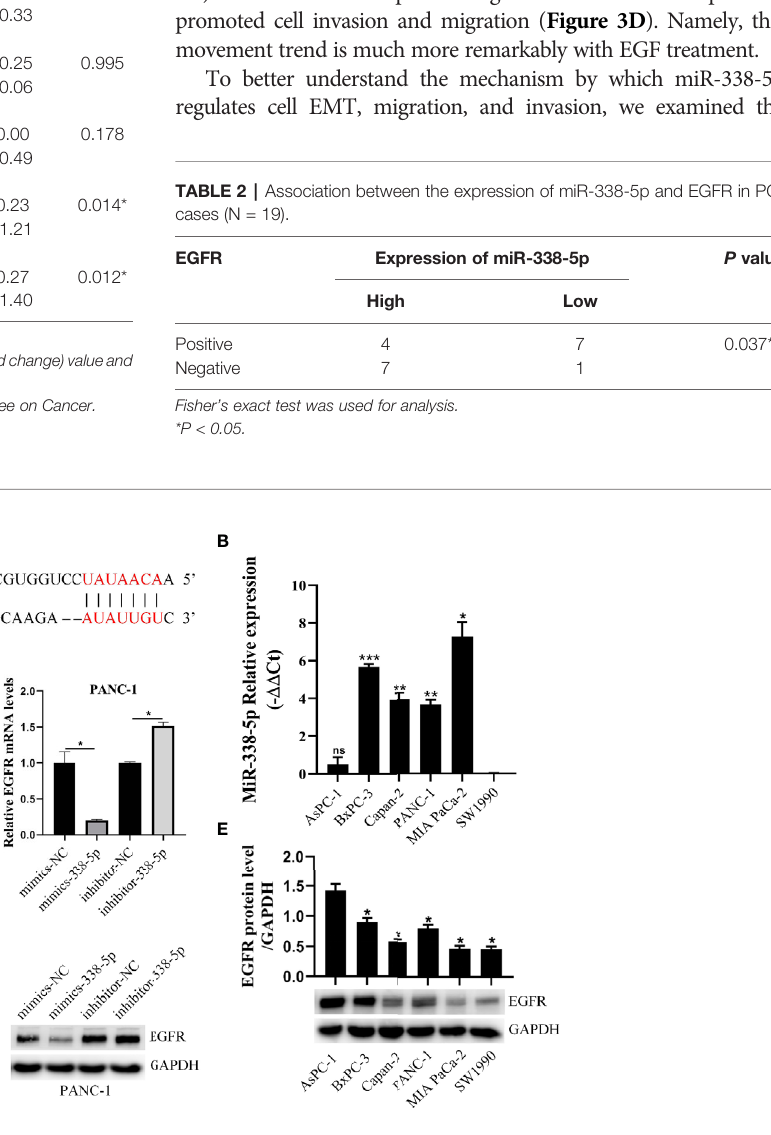
FIGURE 2 | miR-338-5p downregulated the expression of EGFR at the post-transcriptional level. (A) The interaction between miR-338-5p and the 3 ’ -untranslated region of EGFR was predicted by TargetScan software. (B) qRT-PCR analysis of miR-338-5p expression in six PC cell lines and all cell lines are calibrated with SW1990. (C, D) qRT-PCR analysis of EGFR mRNA expression following transfection with the miR-338-5p mimics, miR-338-5p inhibitor, and their respective normal control in Capan-2 (C) and Panc-1 (D) . (E) Western blot analysis of EGFR expression in six PC cell lines and all cell lines are calibrated with AsPC-1. (F, G) Western blot analysis of EGFR expression following transfection with the miR-338-5p mimics, miR-338-5p inhibitor, and their respective normal control in Capan-2 (F) and PANC-1 (G) . All data are shown as the mean ± SEM. *P < 0.05; **P < 0.01; ***P < 0.001.